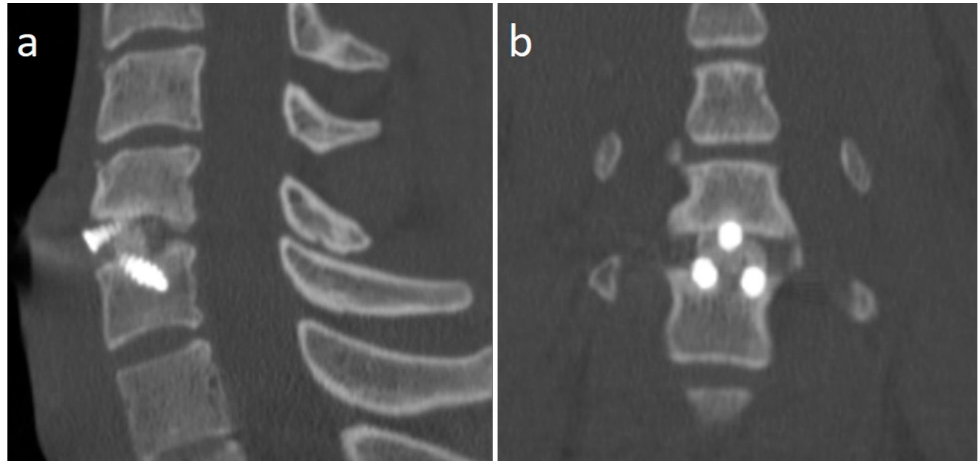
Figure 3. CT scan sagittal ( a ) and coronal ( b ) images of the cervical spine 3 months after surgery, showing the formation of bone bridges as a sign of initial arthrodesis.